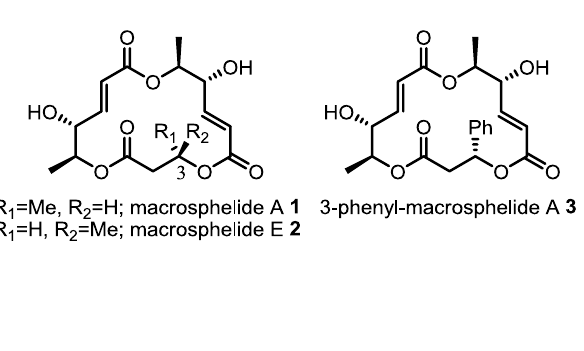
Figure 1. Structures of macrosphelide A, E and 3-phenylmacrosphelide